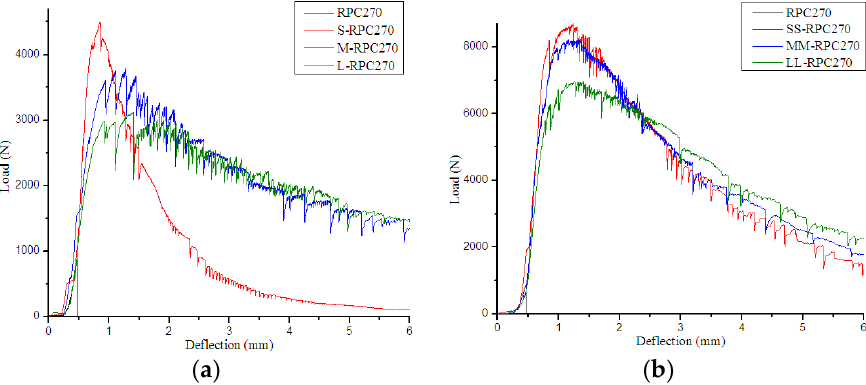
Figure 5. Flexural load–deflection curves for RPC270: ( a ) 0.5% fiber content and ( b ) 2.0% fiber content.